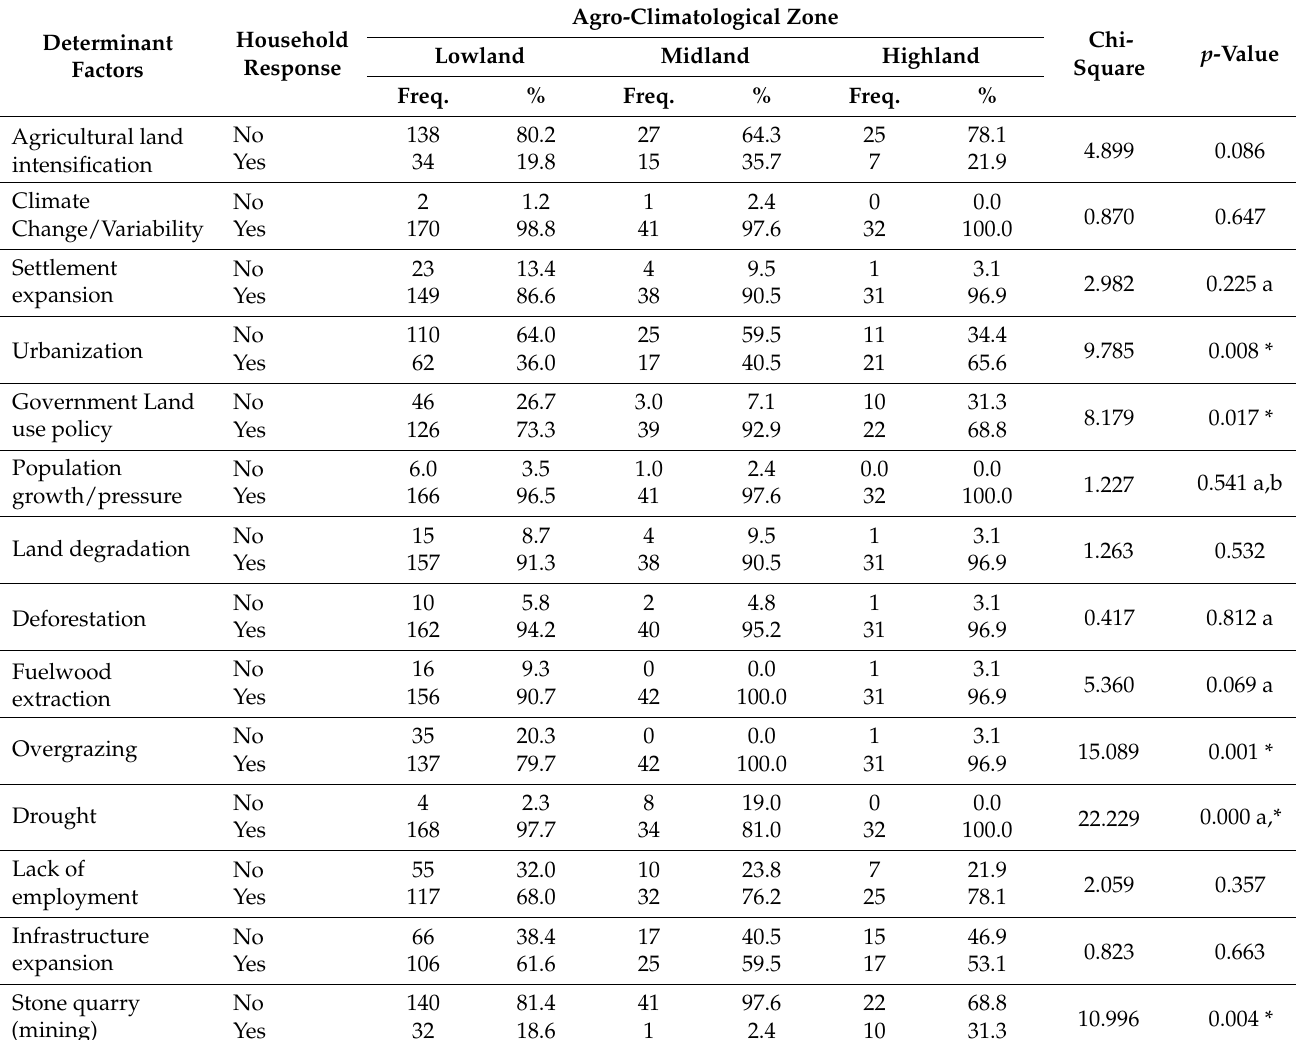
Table 5. Response of households on determinants of LULCC across agro-climatology in Raya Valley, Southern Tigray,